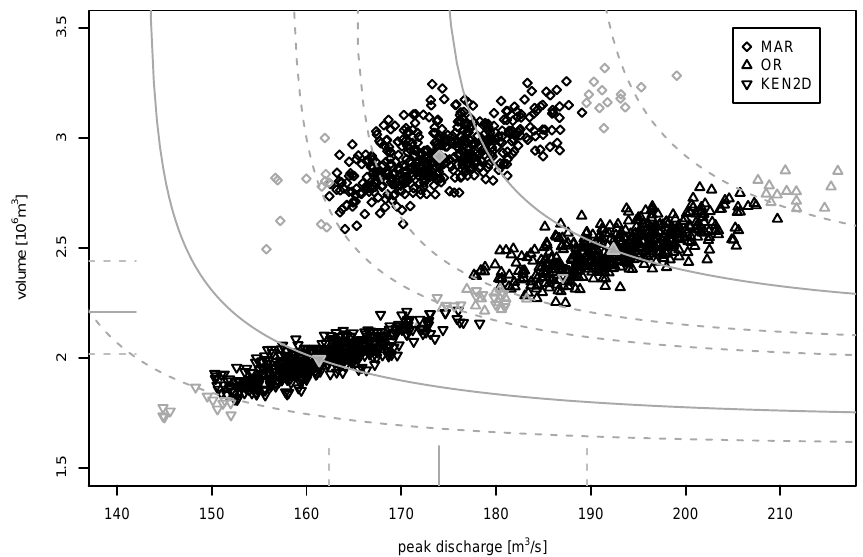
Fig. 10. 500 simulations of different approaches to obtain a single design event with a design return period of 10yr. Straight line segments indicate the univariate approaches and curved lines represent the bivariate approaches, with dashed lines approximating the ensemble con- fidence band estimates for their corresponding point cloud each. The estimated design events are denoted as filled shapes. The open grey shapes represent the most and least extreme 2.5% for each